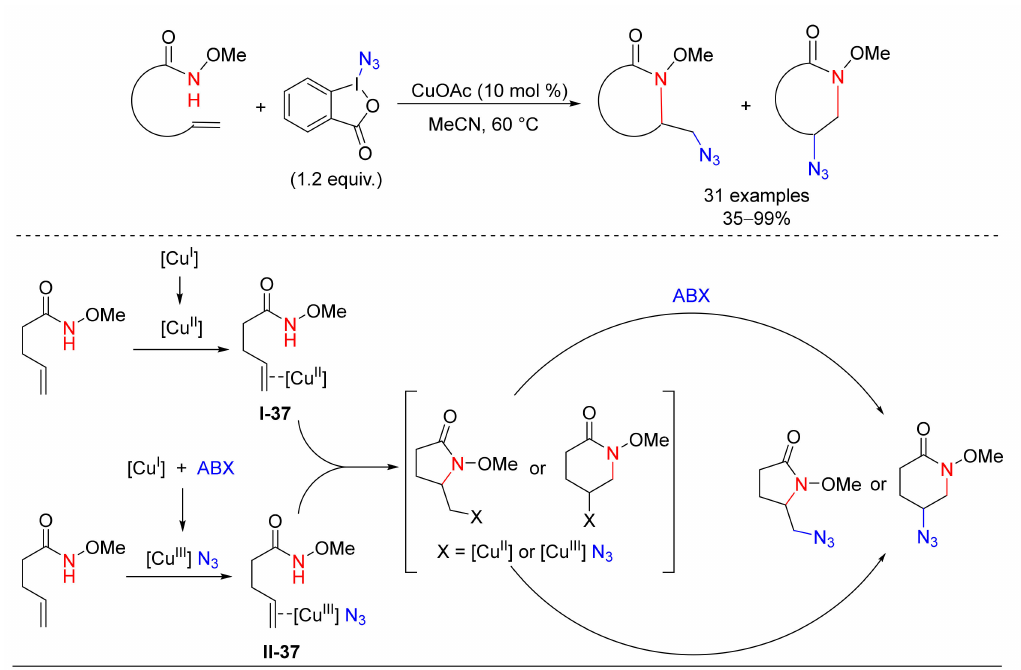
Scheme 37. Copper catalyzed aminoazidation of